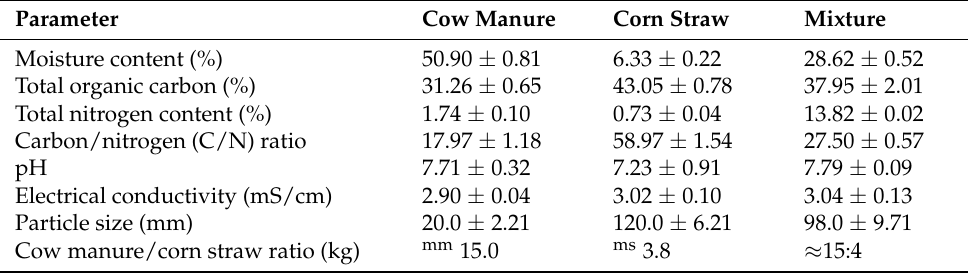
Table 1. Initial physicochemical constituents of cow manure, corn straw and a mixture of cow manure and corn straw used to assess the effect of the moisture regime on the emission pattern of gases and the evolutionary dynamics of physicochemical indices during composting.